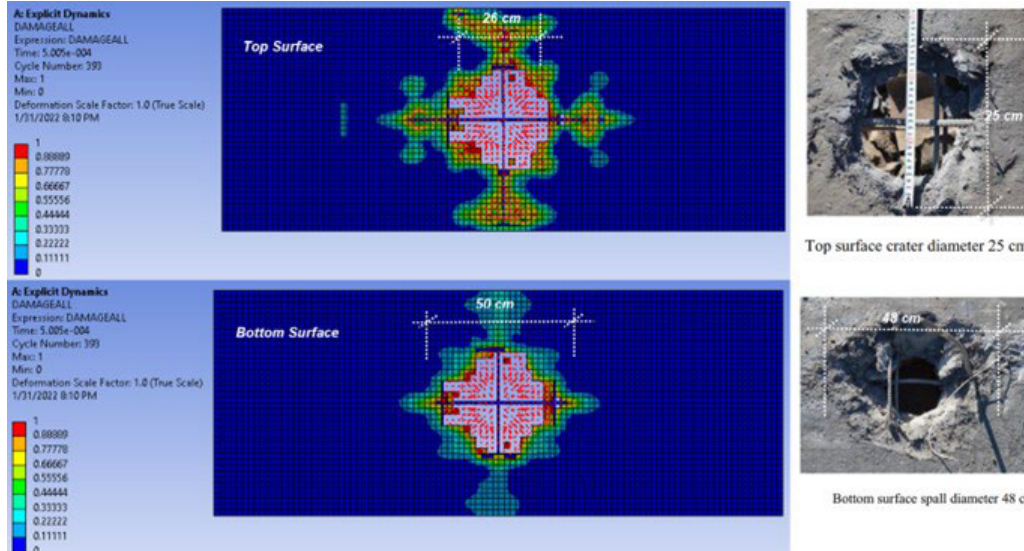
Figure 12 – Comparison between experimental damage & FE damage of UHPC-7 Slab